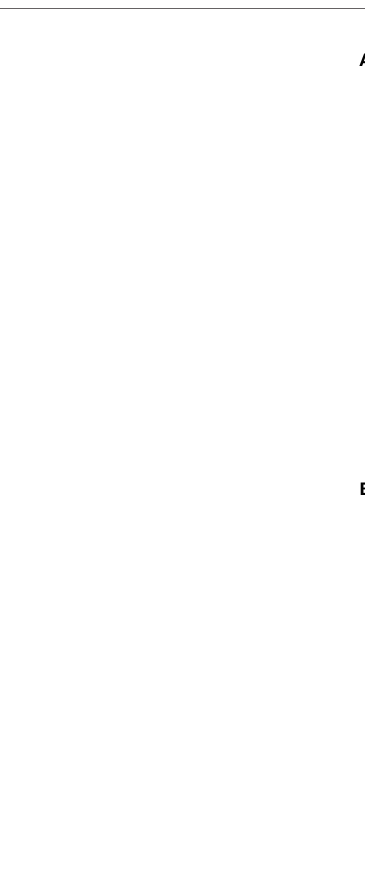
FIGURE 6 | Kaplan-Meier estimates for (A) interval between initial diagnosis of malignant melanoma to euthanasia in CNS+ and CNS- dogs, demonstrating no signi fi cant difference in median survival (p=0.580). Dogs with unknown dates of diagnosis and dogs who exhibited signs prior to diagnosis were excluded. (B) The interval between onset of neurological signs to humane euthanasia was 9.5 days (n=14). Comparisons in survival made by Mantel-Cox Log-rank